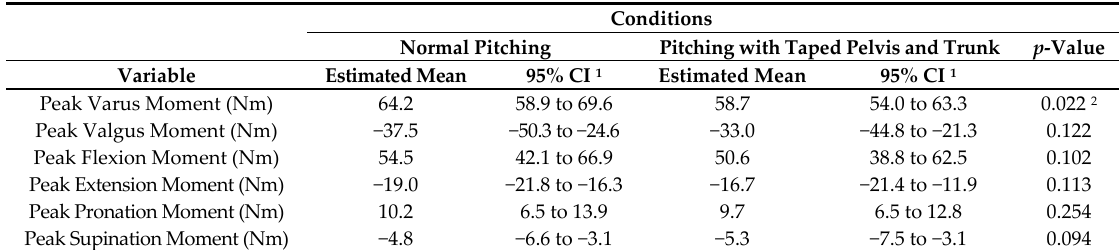
Table 2. Peak internal net elbow moments for the conditions of normal pitching and pitching with taped pelvis and trunk estimated with GEE (N =